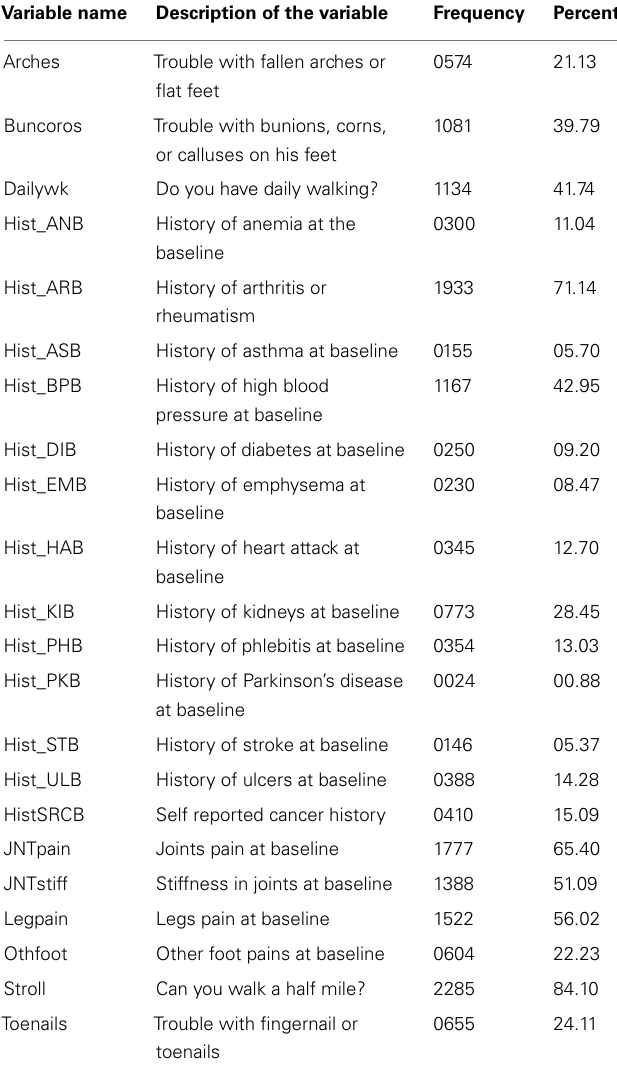
Table 1 | Frequency table and description of the study